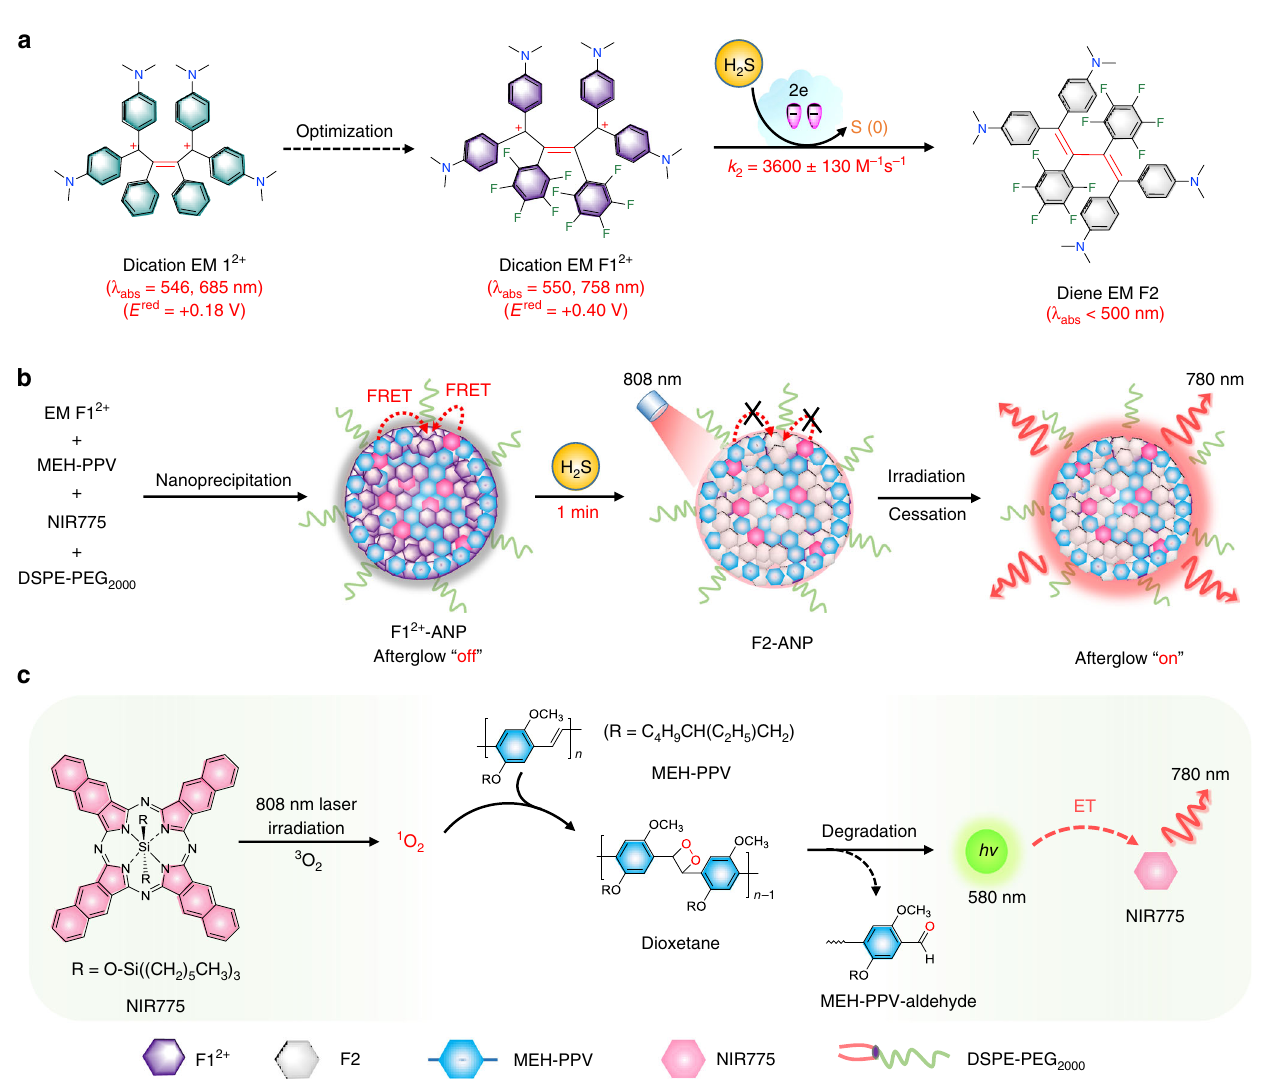
Fig. 1 Schematic illustration of the design of F1 2 + -ANP. a Optimization of dication EM 1 2 + into F1 2 + by introducing two electron-withdrawing penta fl uorophenyl groups, and proposed chemical conversion of F1 2 + into diene F2 upon reduction by H 2 S. b Preparation of F1 2 + -ANP and proposed mechanism of H 2 S-mediated fast activation of NIR afterglow luminescence at 780 nm following pre-irradiation with an 808-nm laser. c The detailed photoreaction processes to produce NIR afterglow luminescence within activated F1 2 + -ANP (i.e., F2 -ANP). F1 2 + -ANP was designed to contain hydrophobic EM F1 2 + , MEH-PPV, and NIR775 via DSPE-PEG 2000 -assisted nanoprecipitation. F1 2 + -ANP is initially afterglow “ off ” owing to the presence of F1 2 + that can quench both the fl uorescence and 1 O 2 production of MEH-PPV and NIR775 via two ef fi cient FRET processes. Upon reaction with H 2 S, F1 2 + was reduced into F2 , and the FRET-based quenching processes were eliminated within F2 -ANP, resulting in the recovery of fl uorescence and 1 O 2 production capacity. Upon irradiation with the 808-nm laser, NIR775 can sensitize 3 O 2 to generate 1 O 2 , which then oxidizes the vinylene bond of MEH-PPV to form unstable dioxetane. After cessation of irradiation, the subsequent slow degradation into MEH-PPV-aldehyde and releases photons at 580